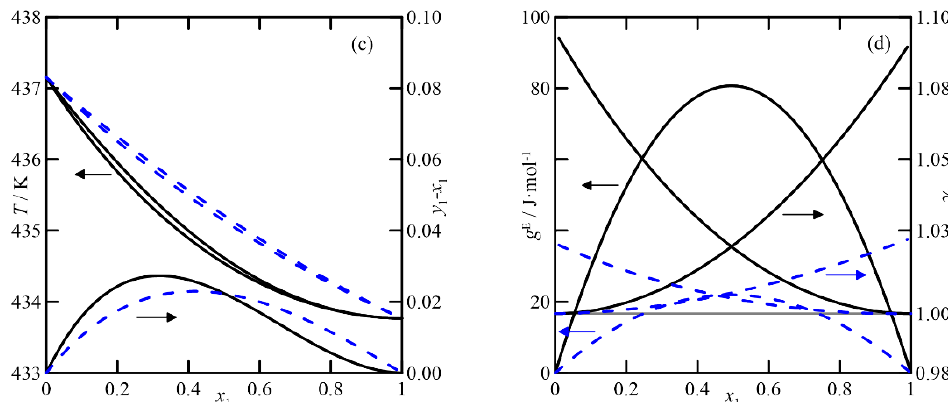
Figure 10. VLE at 101.32 kPa of: ( a , b ) cyclohexanol + 2-cyclohexen-1-ol, and ( c , d ) cyclohexanol + 3-cyclohexen-1-ol. (----) UNIFAC-DM; (- - -) COSMO-RS.